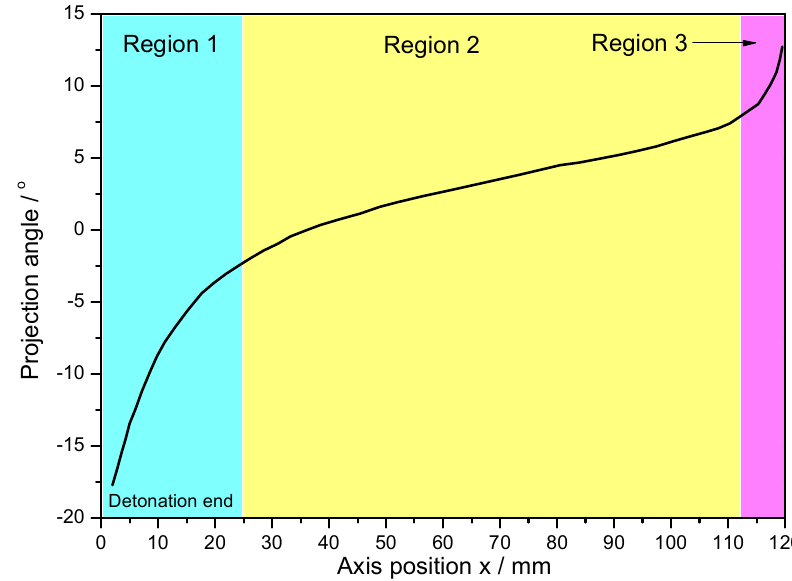
Figure 6. Projection angle axial distribution.